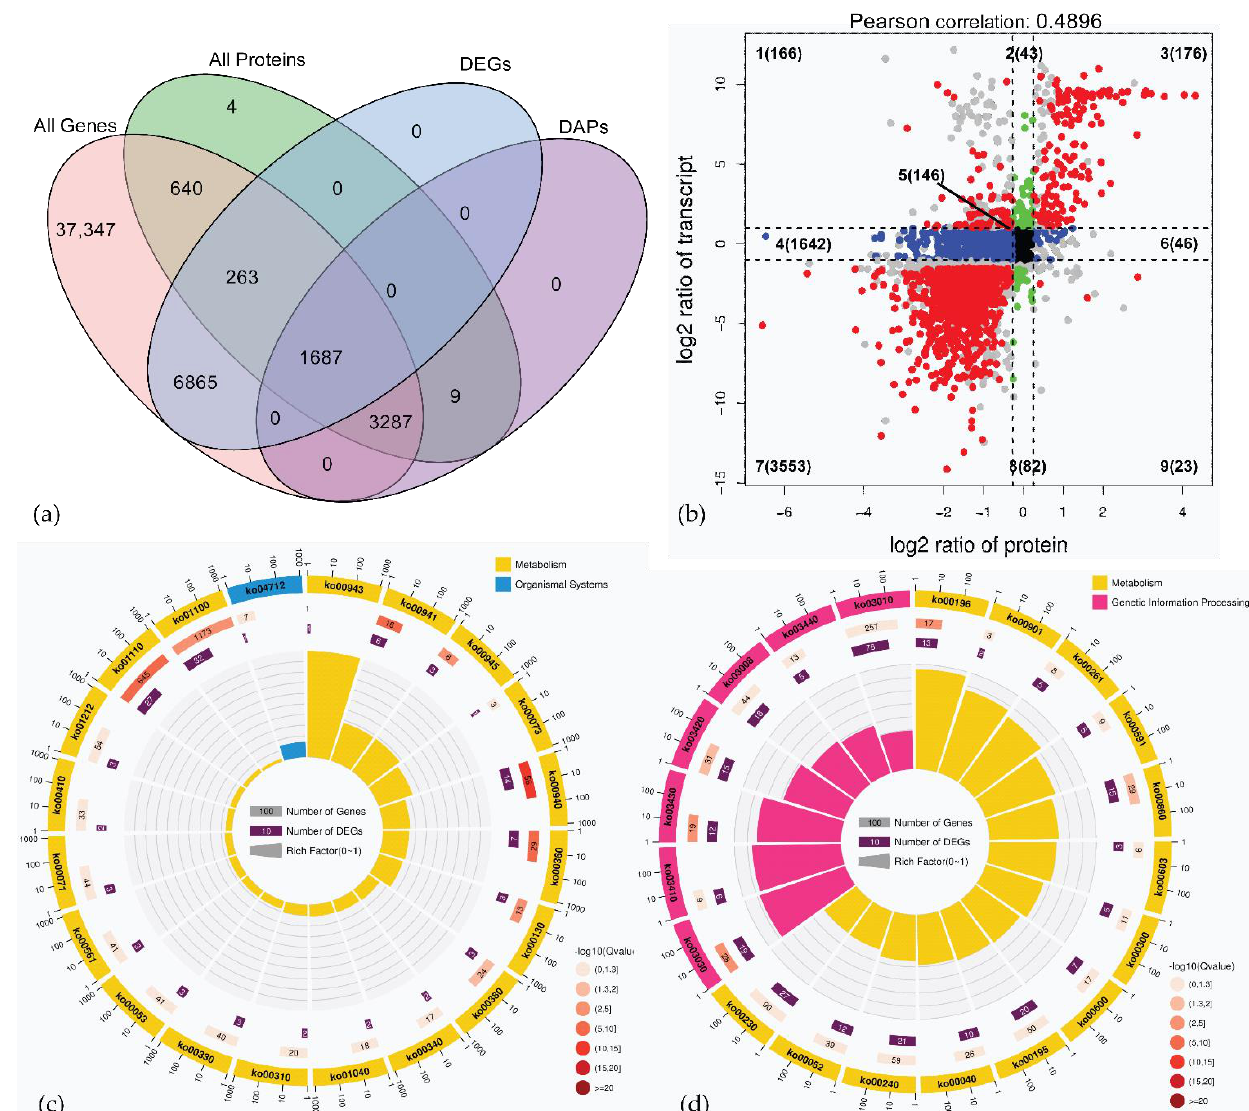
Figure 3. ( a ) Venn diagram of DEGs in all genes and DAPs in all proteins; the description of what is contained in the first panel; ( b ) scatter plot of nine-quadrant associate analyses of transcripts and proteins in Pv-1 and Pv-2. Each dot represents a gene/protein. The dashed line on the abscissa represents the FC threshold of DEGs (FC ≥ 2.0), the dashed line on the ordinate represents the FC threshold of DAPs (FC ≥ 1.2), the genes/proteins outside the threshold line are DEGs/DAPs, and the genes/proteins inside the threshold line are not DEGs/DAPs. Numbers 1 – 9 represent each quadrant, and the number of points in each quadrant showed in parentheses. Quadrants 1, 2, and 4 indicate that the protein abundance was lower than the RNA expression. In 3 and 7, the RNAs correspond with the related proteins. Quadrant 5 represents that the proteins and transcripts were commonly expressed with no difference. Quadrants 6, 8, and 9 indicate that the protein abundance was higher than the RNA expression. (If the FC is reached and the p value is not reached, it will be shown as the gray point). Top 20 of KEGG pathway enrichment of DEGs/DAPs in quadrant 3 ( c ) and quadrant 7 ( d ). The first circle: numbers outside of the circle are the coordinate rulers of the gene number, different colors represent different KEGG A classes; the second circle: the number and Q -value of the KEGG pathway in the background gene. The more genes, the longer the bars, and the smaller the Q -value, the redder the color; the Q -value is the p -value corrected by the FDR method. The third circle: a bar chart of the proportion of up and down-regulated genes, dark purple represents the proportion of up-regulated genes, and light purple represents the proportion of down-regulated genes; the specific values are shown below. Fourth circle: RichFactor value of each KEGG pathway.